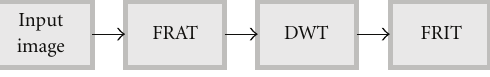
Figure 4: FRIT block